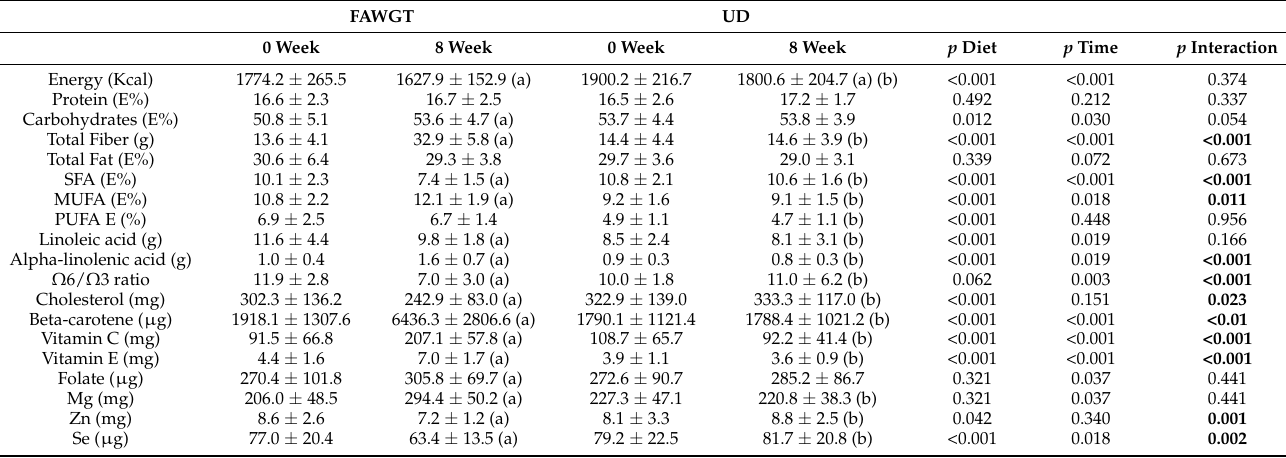
Table 3. Dietary composition at baseline and after 8 weeks of